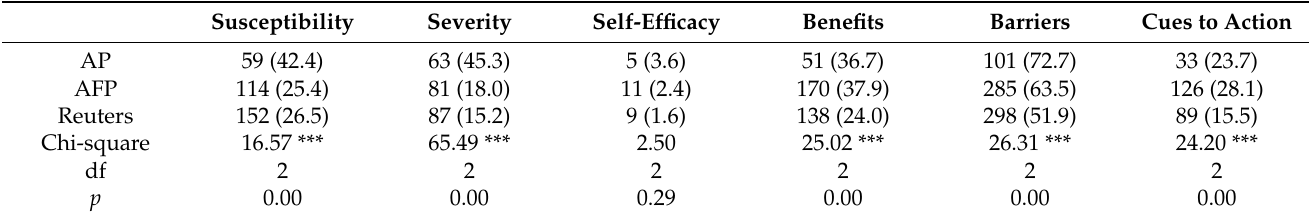
Table 4. The frequency of HBM constructs used by three news